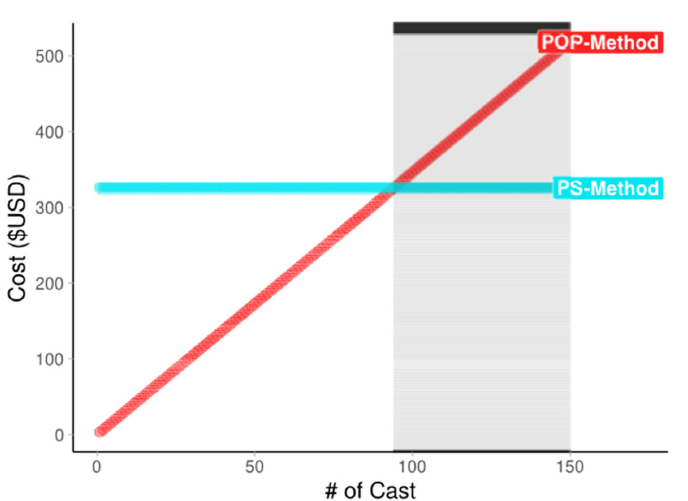
Figure 5. Plot illustrating initial and long-term costs of both casting systems. Note: #: number of cast, POP: plaster of paris, PS: polystyrene bead. # of cast: the number of casts and associated cost per cast from 0 to 150 prosthetic castings for both casting methods. Black horizontal line and gray shaded bar indicate the point at which additional POP castings become costlier than the PS casting